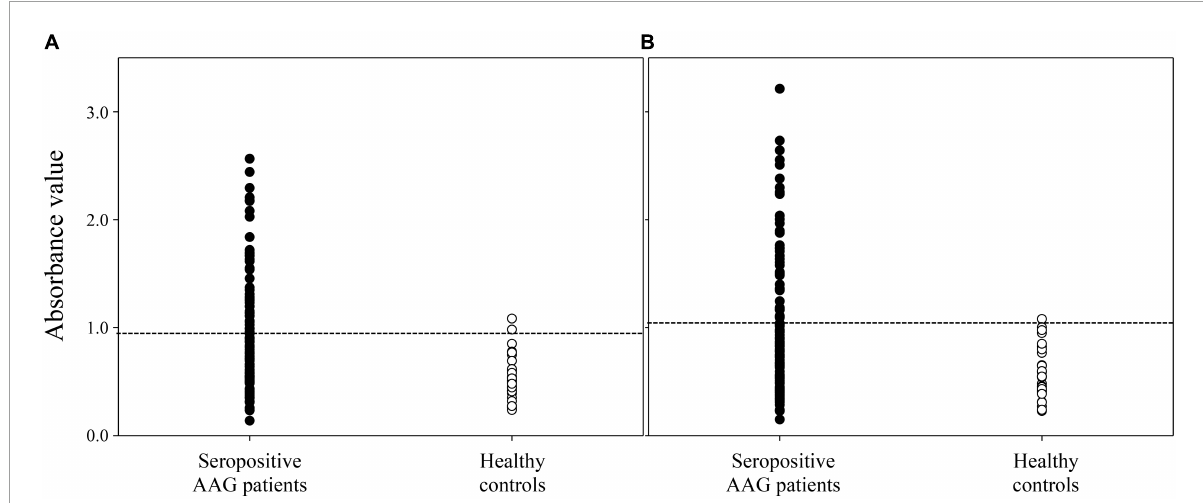
FIGURE6 Detection of anti-P1 and P2 antibodies by ELISA. We tested sera from seropositive patients with human autoimmune autonomic ganglionopathy (hAAG) and healthy controls. The results of a test based on the ELISA show that 45.0% (49 of 109) of the sera from seropositive patients with hAAG are positive for anti-P1 and/or P2 Abs. (A) The anti-P1 Abs were detected in 43 samples (39.4%) from patients with hAAG, conversely, these Abs were detected in only two sample (6.3%) from healthy controls ( p < 0.001). The mean anti-P1 level in healthy controls is 0.522 absorbance value (AV), which is significantly different from the value for the samples from patients with hAAG, which have a mean titer of 0.927 AV ( p < 0.001). (B) The anti-P2 Abs were detected in 40 samples (36.7%) from patients with hAAG conversely, these Abs were detected in only one sample (3.1%) from healthy controls ( p < 0.001). The mean anti-P2 level in healthy controls is 0.573 AV, which is significantly lower than the value for the samples from patients with hAAG, which have a mean level of 1.029 AV ( p <